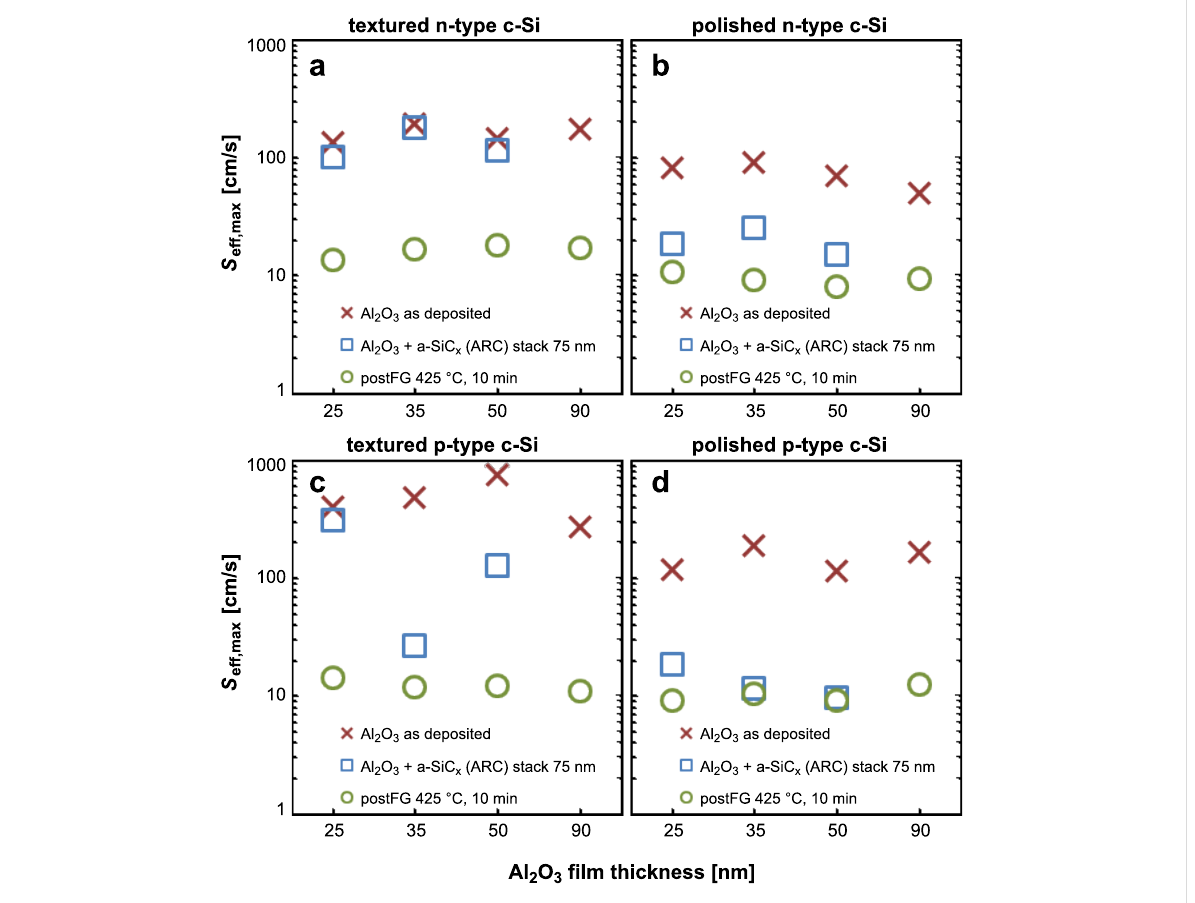
Figure 1: Surface recombination velocity, S eff,max [cm/s]. (a) and (b) S eff,max for randomly textured and polished n-type wafers respectively. (c) and (d) S eff,max for randomly textured and polished p-type wafers respectively. S eff,max was determined at 1-sun injection level as a function of the Al 2 O 3 thickness. The aluminum oxide layers were complemented up to 75 nm with an a-SiC x